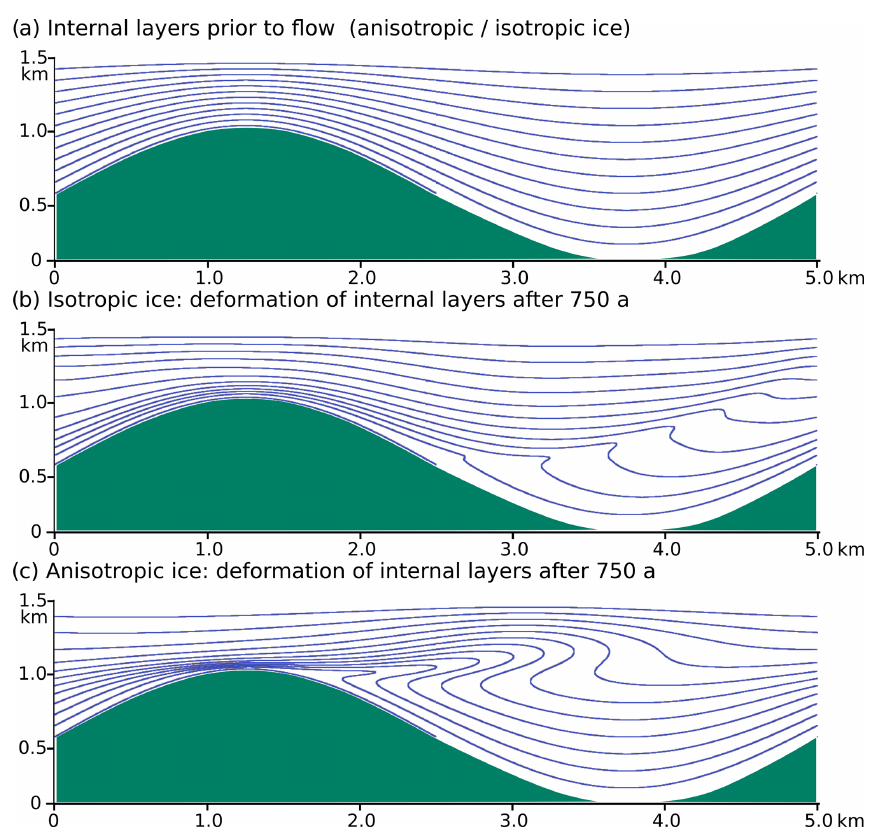
Figure 9. Marker lines prior to (a) and after 750 years of flow of (b) isotropic and (c) anisotropic ice. The axial plane of the resulting shear fold in isotropic ice mimics the bedrock topography, while it is controlled by shearing along a horizontal shear zone in the case of anisotropic ice. Green: bedrock, flow to the right.